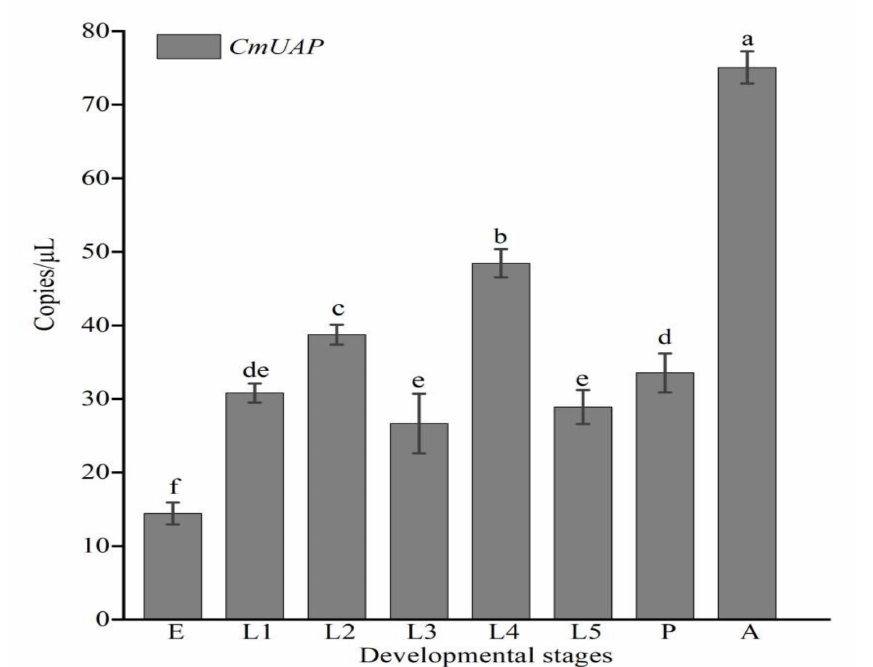
Figure 4. Expression levels of CmUAP at different developmental stages. E, Egg; L1–L5, first-fifth- instar larvae; P, Pupa; A, Adult. Each bar represents the mean ± SD. Different letters above the bars indicate significant differences at p < 0.05 based on Duncan’s